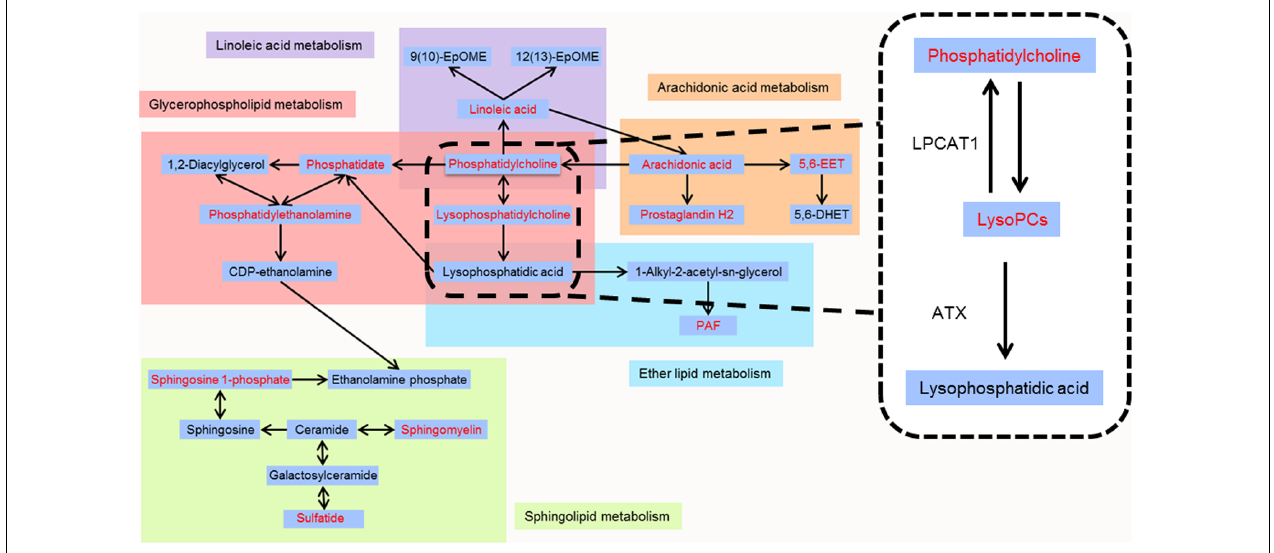
FIGURE 10 | Metabolic pathways of identified metabolites. Red color represents metabolites whose content in cinnabar and reaglar co-administration group is significantly different when compared with that in saline control